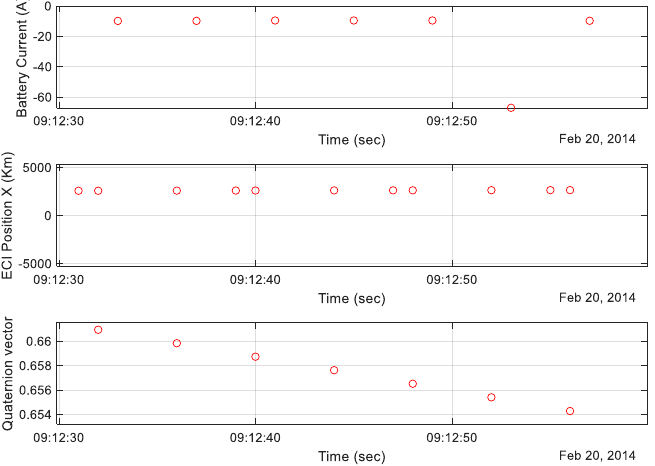
Figure 7. KOMPSAT-5 on-orbit current, position, and attitude data.